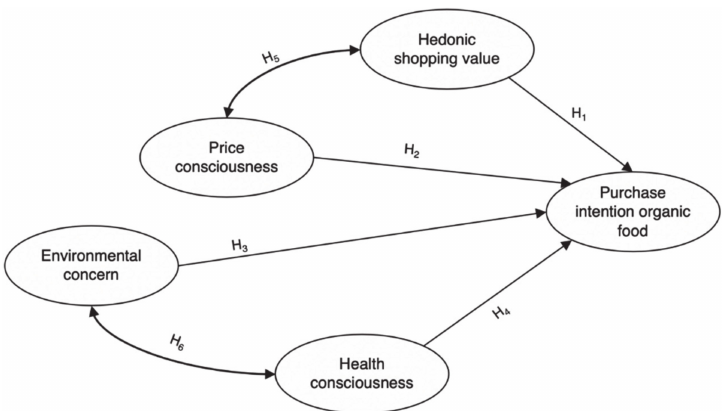
Figure 1. Conceptual framework. Note: H 1 to H 6 denote the stated